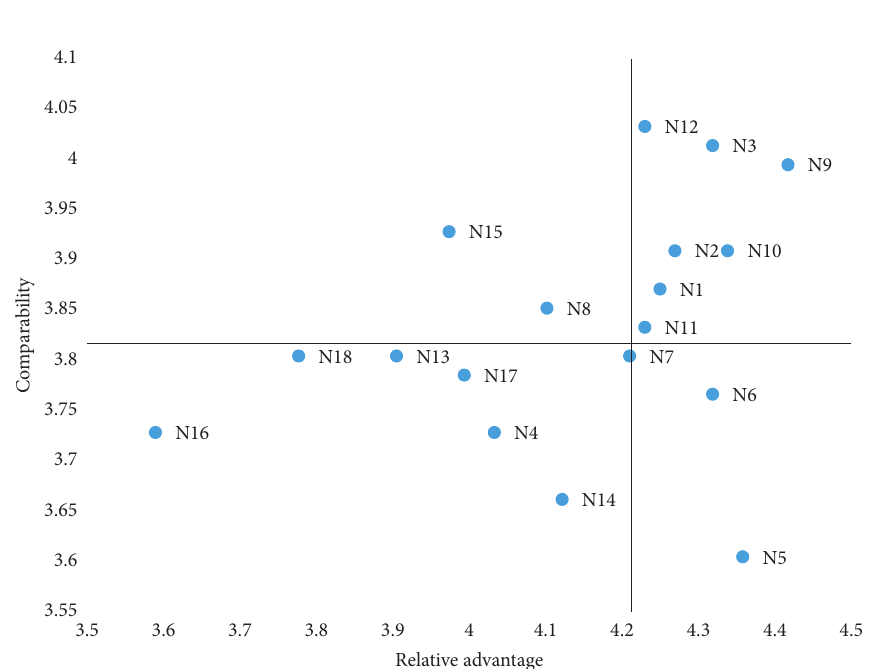
Figure 1: The relationship between the relative advantage and compatibility of the application